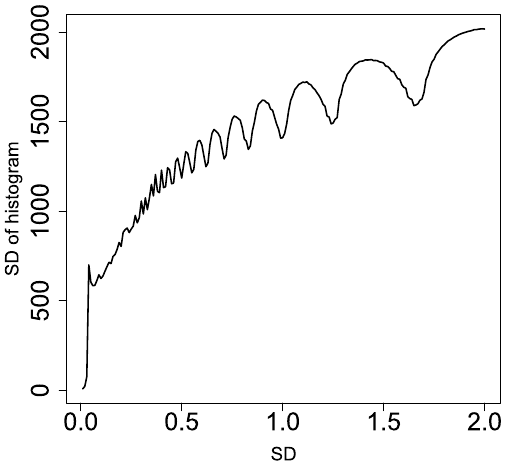
Figure 7. σ h , defined in Eq. (22) as a function of SD used for computing P i in Eq. (19) using MAQC data.